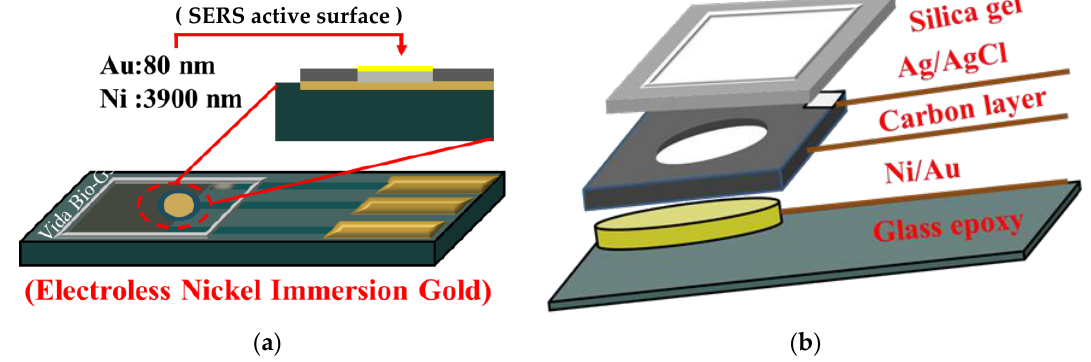
Figure 1. Screen-printed electrode—( a ) oblique top view and ( b ) exploded view.